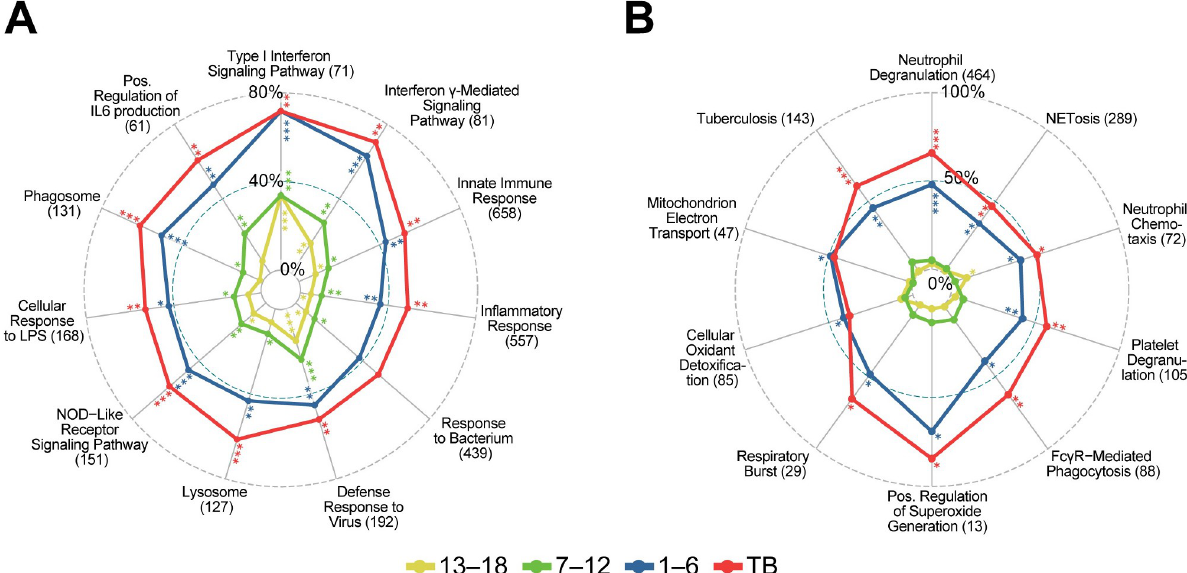
Fig 2. GO annotations and KEGG pathways first enriched at (A) 13–18 and 7–12 months before diagnosis and (B) 1–6 months before diagnosis. Radar plots illustrating proportions of DE genes in the gene sets at the indicated time points for selected pathways broadly related to neutrophil function. All four time points [13–18, 7–12, and 1–6 months before, and at diagnosis (TB)] are shown in each plot to demonstrate that annotations detected early persist and generally have more DE genes at later stages, although significance may decrease. The numbers in parenthesis represent the total numbers of genes in the annotation gene set. Asterisks indicate nominal significance: ��� , < 5e -15 ; �� < 5e -07 ; � , < 5e -04